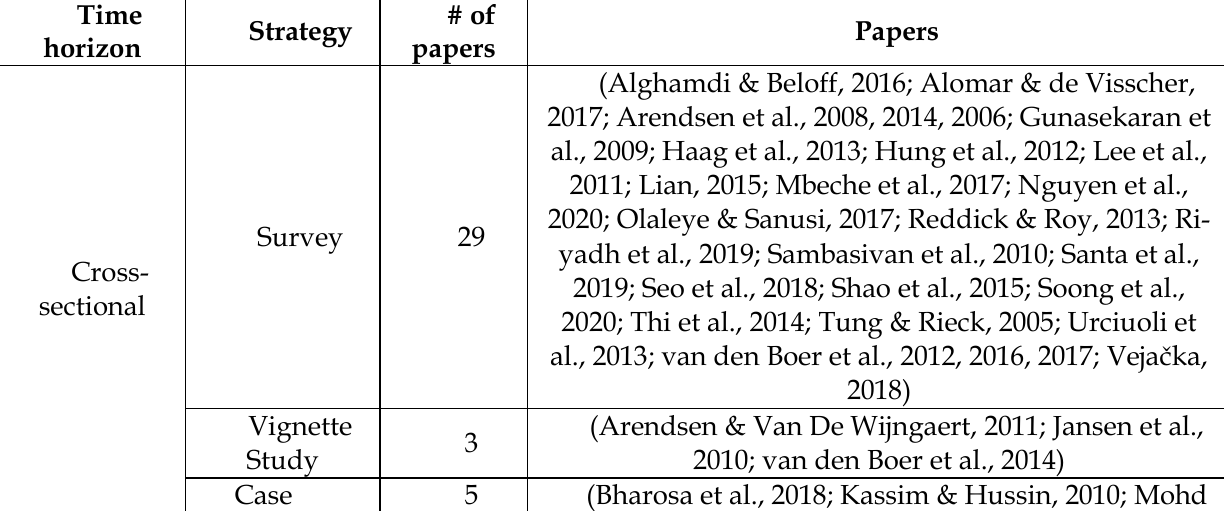
Table 8: Time horizon and research strategy Time